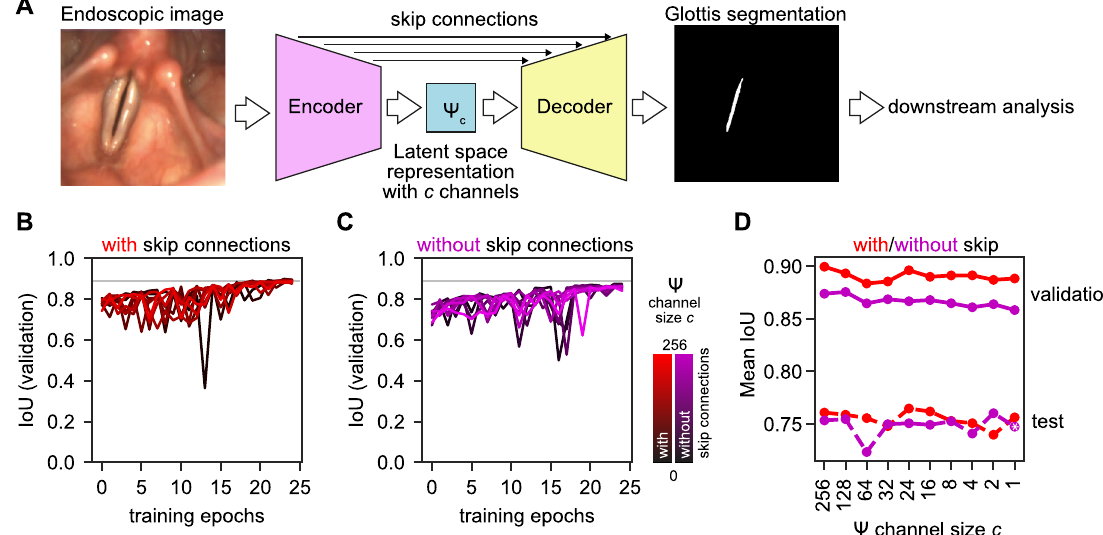
Figure 1. A single latent space channel is sufficient for glottis segmentation. ( A ) Glottis segmentation of endoscopic images using deep neural networks (DNNs) with latent space (cid:31) . ( B ) Convergence of segmentation DNNs across different latent space channels with enabled skip connections. Gradient from black to red indicates fewer channels. The gray line indicates maximum IoU score. ( C ) Convergence of segmentation DNNs across different latent space channels with disabled skip connections. Gradient from black to magenta indicates fewer channels. The gray line indicates maximum IoU score from panel B . ( D ) Performance of best performing segmentation DNNs on validation set (solid lines) and evaluated on test set (dashed lines) with enabled (with, red) and disabled (without, magenta) skip connections across latent space ( (cid:31) ) channels measured by mean intersection over union (IoU). The asterisk indicates the architecture used in the subsequent